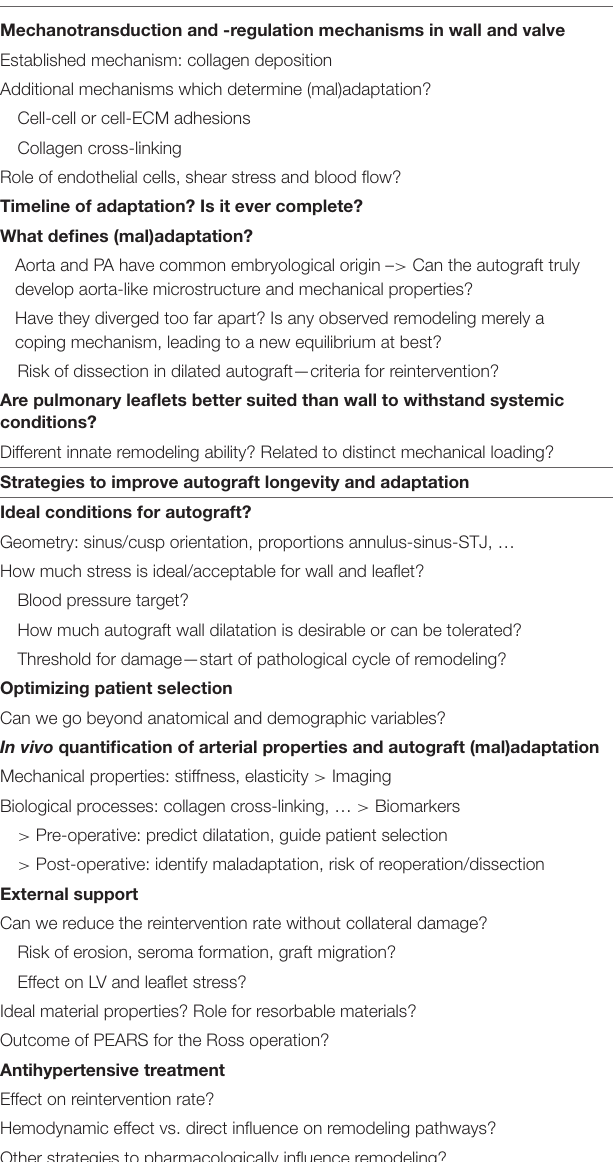
TABLE 3 | Remaining fundamental questions and unmet clinical needs regarding pulmonary autograft remodeling after the Ross procedure. Understanding pulmonary autograft